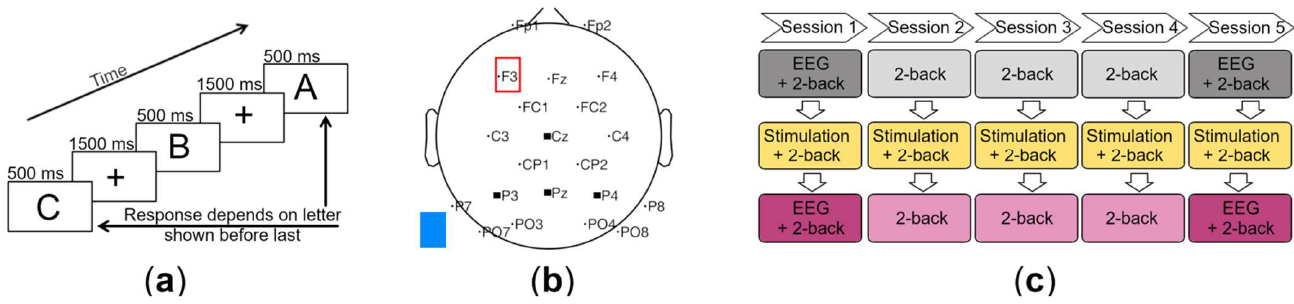
Figure 1. ( a ) The 2-back task. ( b ) EEG channel locations. Black squares mark the electrodes of the parietal-central ROI (Cz, P3, Pz, and P4). The red square marks the anode over F3 as the stimulation electrode, and the blue square marks the cathode as the extracephalic reference electrode. ( c ) Course of the experiment over five consecutive days.